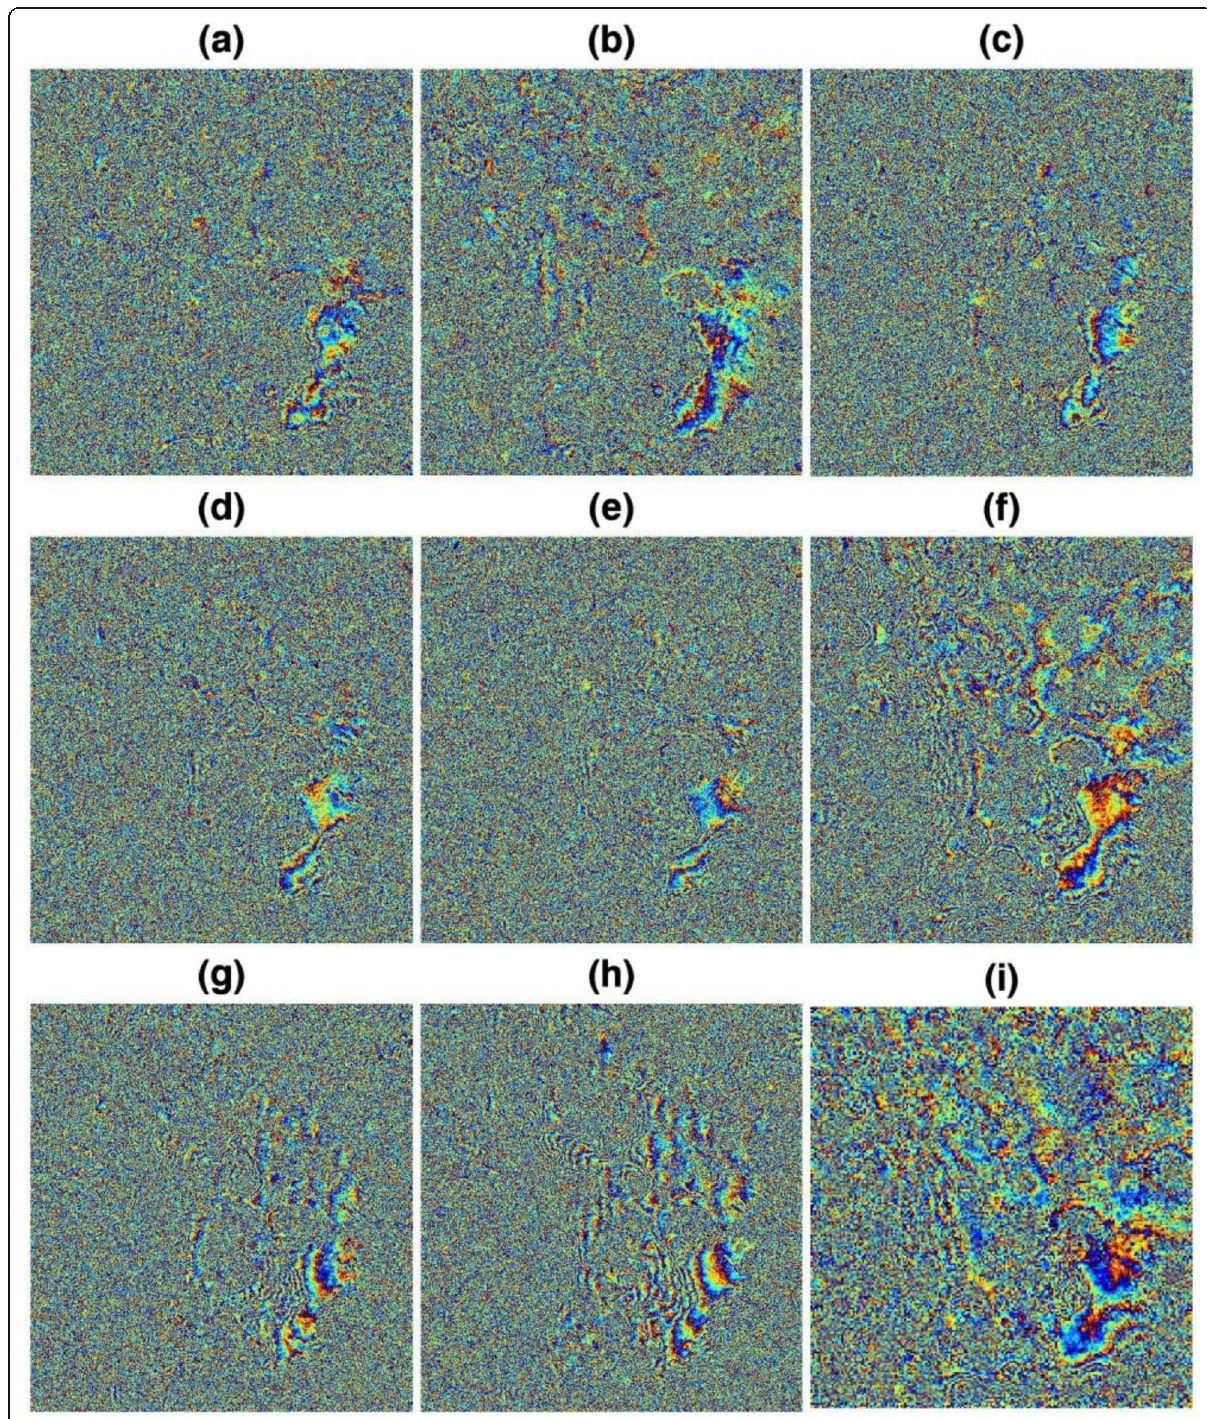
Fig. 6 Differential interferograms (from 51 interferograms) for Mexico City study area. Images (a)-(i) are the interferograms between the master image and radar images acquired on 2003/04/11, 2003/08/29, 2004/09/17, 2004/11/26, 2004/12/31, 2005/07/29, 2005/09/02, 2005/11/11, and 2007/03/16, respectively. (For characteristics of each image, see Table